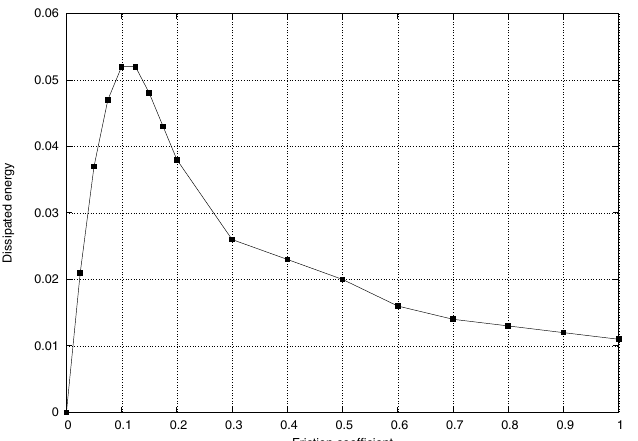
Fig. 6. Deformed configurations at different times (with fric-